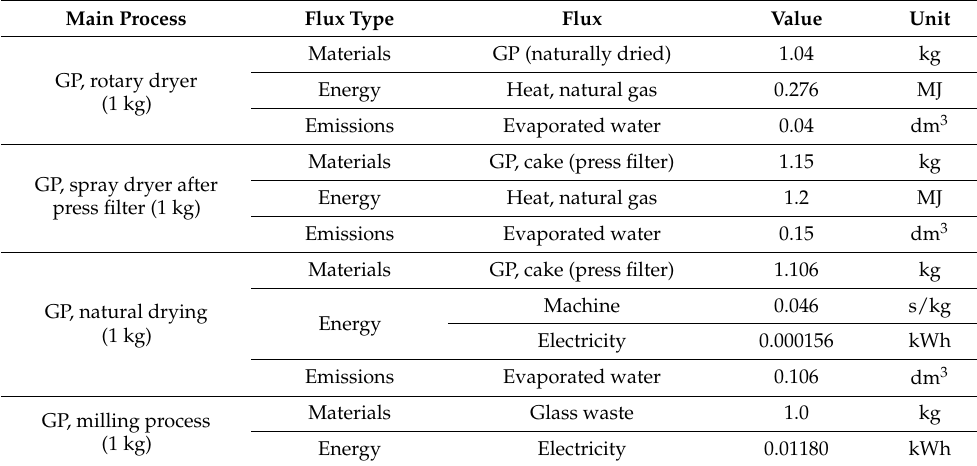
Table 6. Life Cycle Inventory: milling and drying of the waste glass